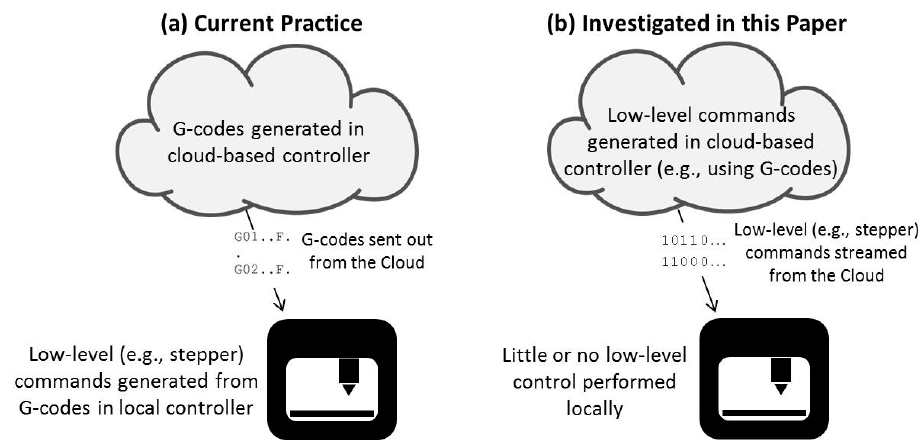
Figure 1. ( a ) Current control of 3D printers from the Cloud using G-codes (e.g., as employed in printer management and web-based wireless host platforms); ( b ) Proposed low-level control of 3D printers from the Cloud intended for 3D printer Control as a Service (3DPCaaS).